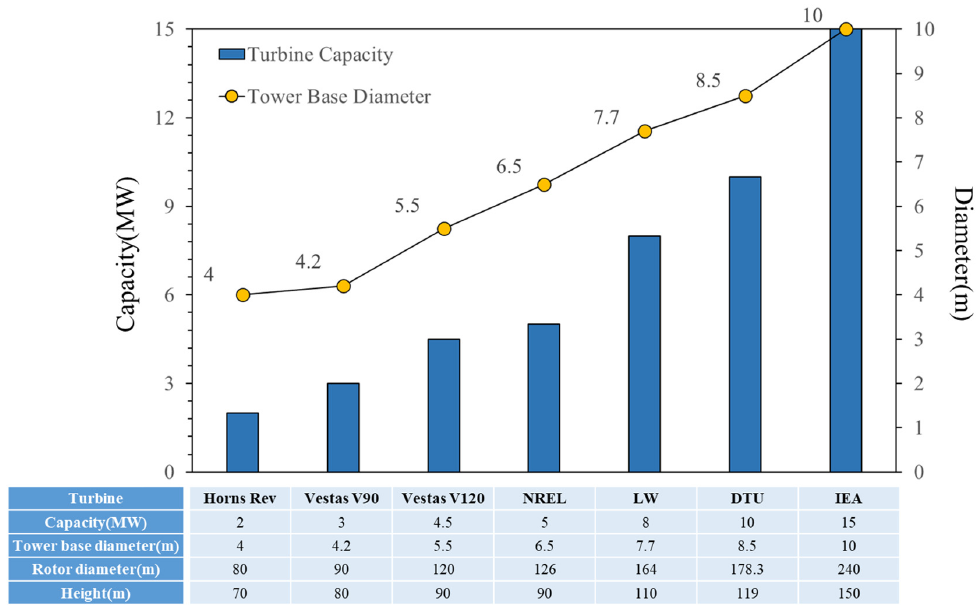
Figure 1. Comparison of resources by turbine capacity and tower base diameter, adapted from refs. [2–7].